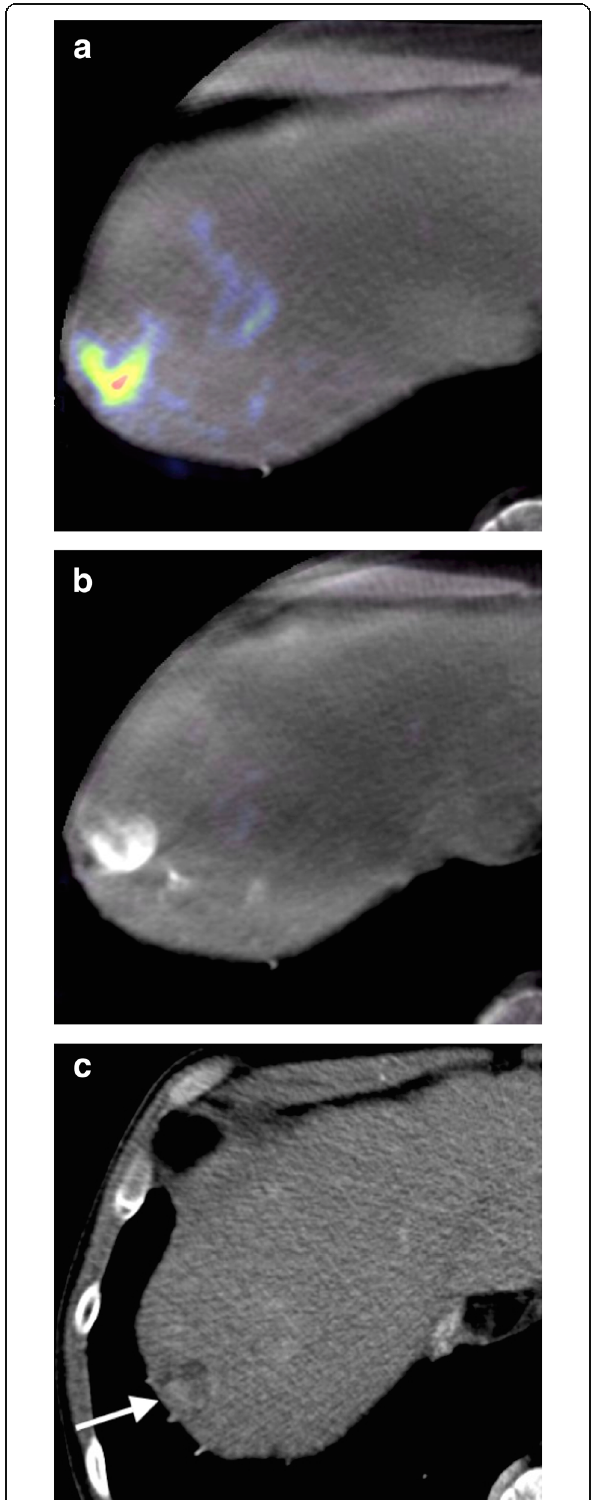
Fig. 3 a Pre-TACE C-arm CBCT PBVI via the proper hepatic artery showing viable tumor. TACE has previously been performed. b C-arm CT PBVI via the proper hepatic artery acquired following TACE showing an apparent complete response of the lesion to treatment. There is high density contrast in the lesion but no evidence of residual tumor perfusion. c Follow-up MDCT showing residual enhancing tumor which was subsequently shown to be supplied by the right